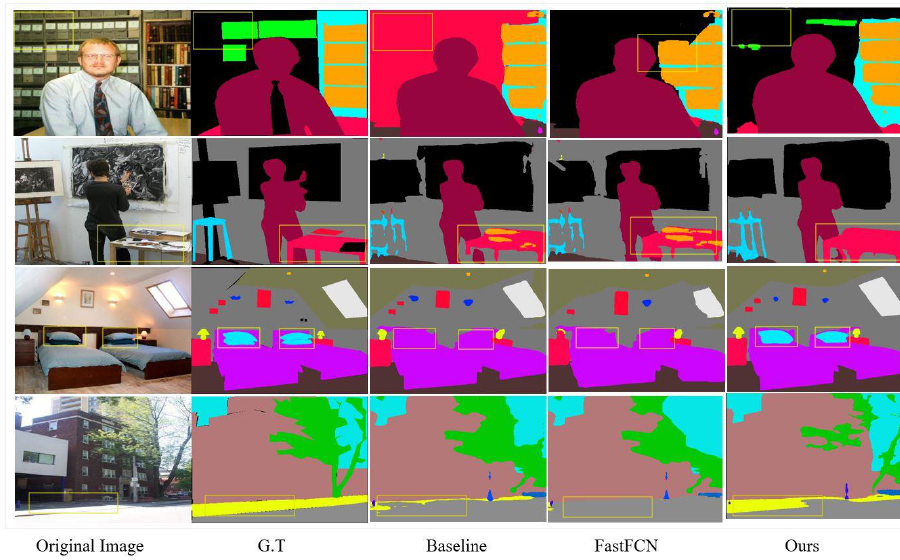
Figure 6. Visual improvements on ADE20k scene parsing dataset. Our method corrects the error of the baseline model and produces more accurate and detailed